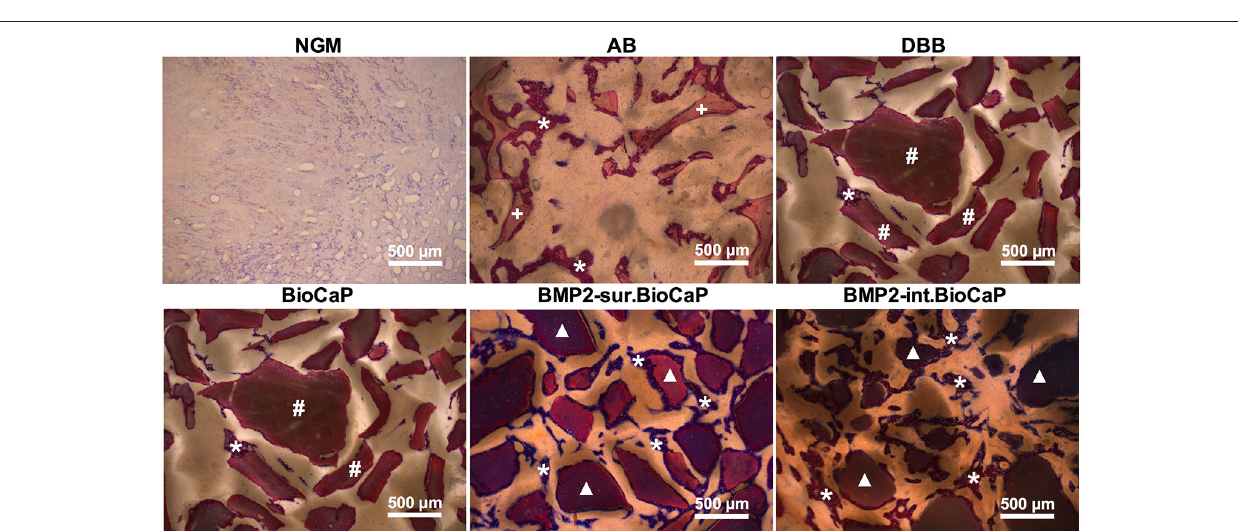
Frontiers in Cell and Developmental Biology |